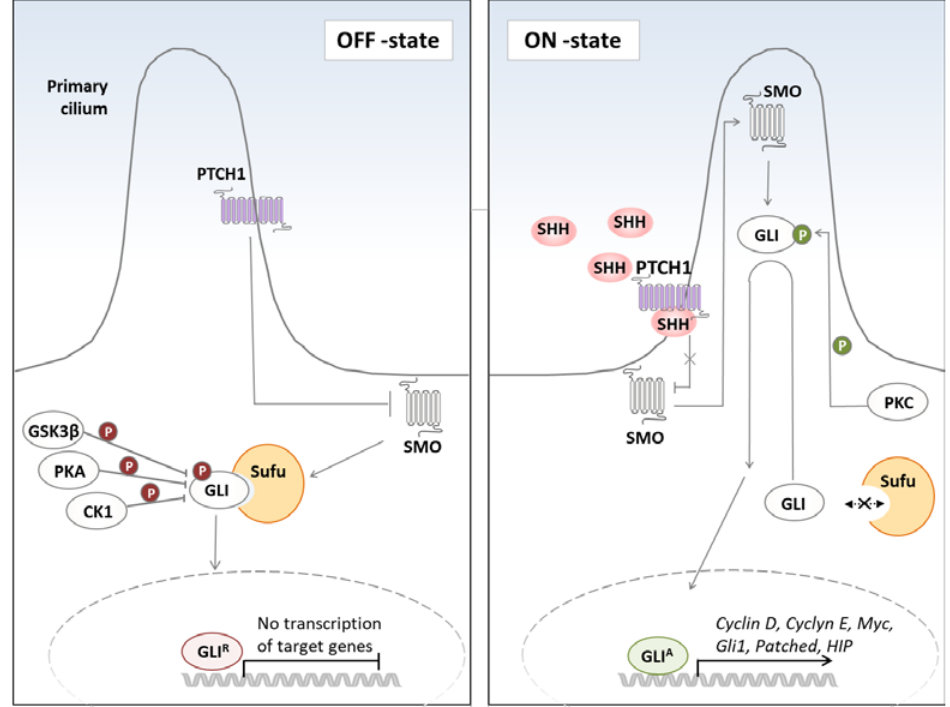
Figure 1. Mechanism of Hedgehog pathway activation. In the absence of the Hh ligand ( left panel), PTCH1, which is found in the primary cilium, binds to SMO and prevents its transclocation into the cilium. This leads to the sequestration of GLIs in the cytoplasm, their association with the negative regulator SUFU, phosphorylation by GSK3 β /PKA/CK1 kinases, and subsequent cleavage into repressor forms (GLI R ). In the presence of the Hh ligand ( right panel), SMO inhibition by PTCH1 is relieved, and SMO translocates to the primary cilium and prevents GLI2 and GLI3 cleavage. GLI proteins dissociate from SUFU, are phosphorylated by PKC, and converted into their active forms (GLI A ), which then translocate to the nucleus and induce target genes expression. (Hh; hedgehog, PTCH1; Patched 1, SMO; Smoothened, GLI; gliomaassociated oncogene, GSK3 β ; glycogen synthase kinase 3 β ; PKA; protein kinase A, CK1; casein kinase 1, SUFU; Supressor of Fused, PKC; protein kinase C).